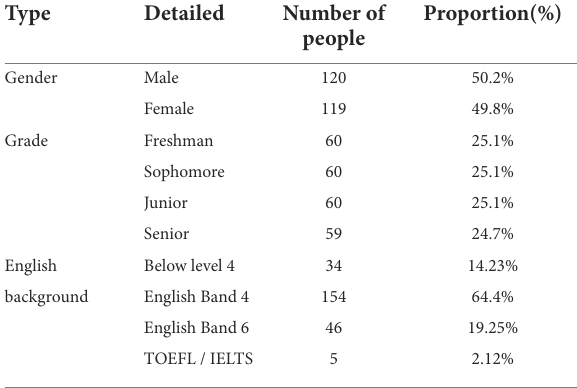
TABLE 1 Characteristics of